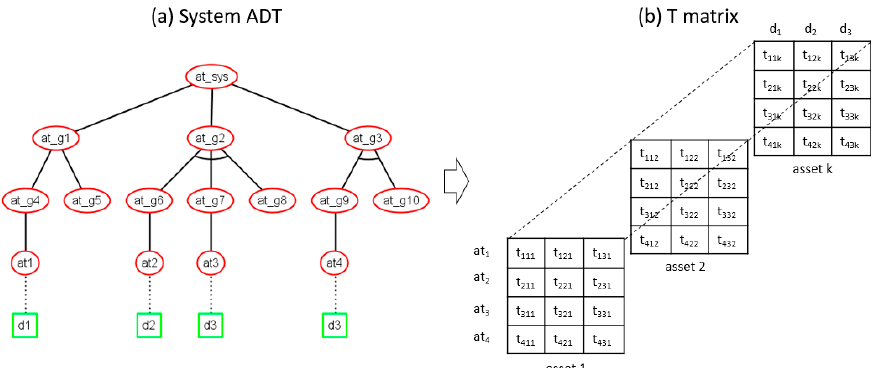
Figure 4. Example of a 3-D relationship matrix T (b) obtained from a system ADT with 4 attack events and 3 defenses on k assets (a).